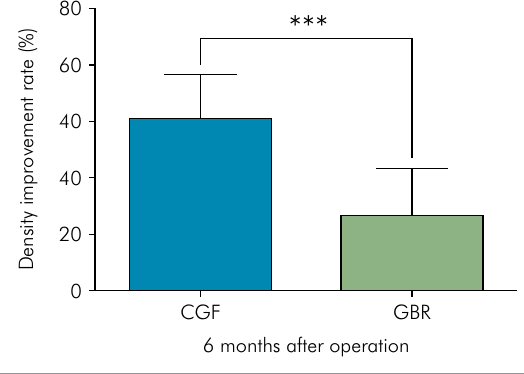
Figure 3. Comparison of the bone density improvement rate between the CGF group and the ADM group at 6 months after alveolar bone grafting (p = 0.0002).